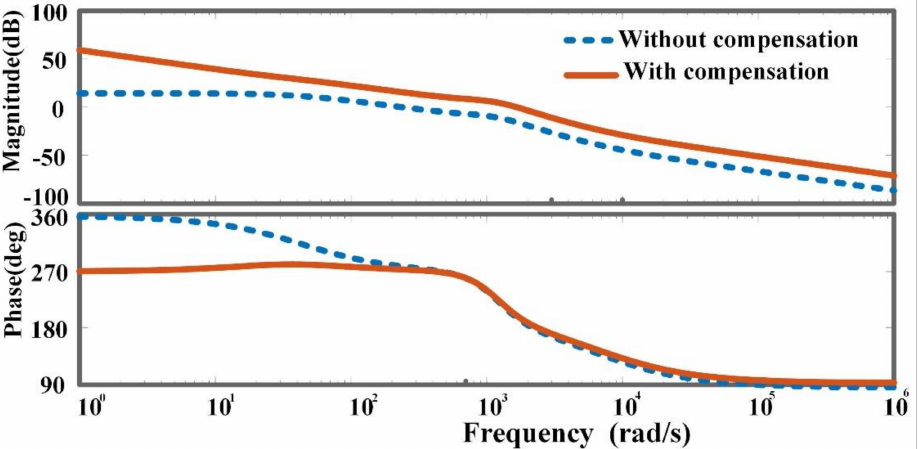
Figure 10. Bode diagram of the outer voltage logic in open loop with and without